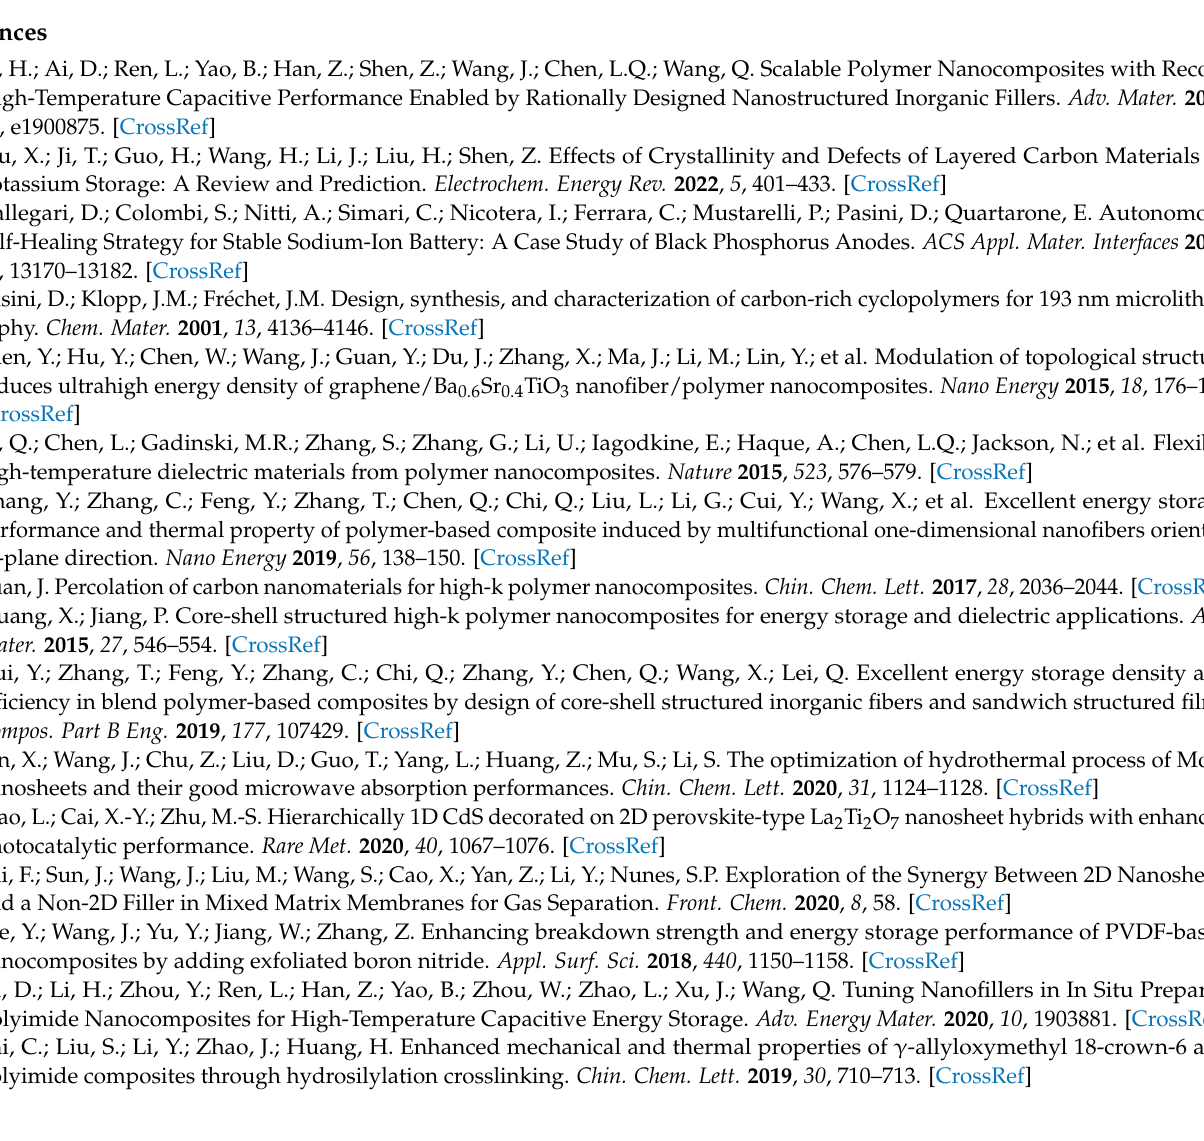
Figure S13: The Lc and La of (a) PVDF/BN@PDA and (b) PVDF/BN@PDA − STNSs composites; Figure S14: M” of the PVDF/BN@PDA − STNSs ternary composites; Figure S15: Hysteresis loops of pure PVDF, PVDF/BN@PDA and PVDF/BN@PDA − STNSs composites; Table S1: DSC results and F( β ) of the